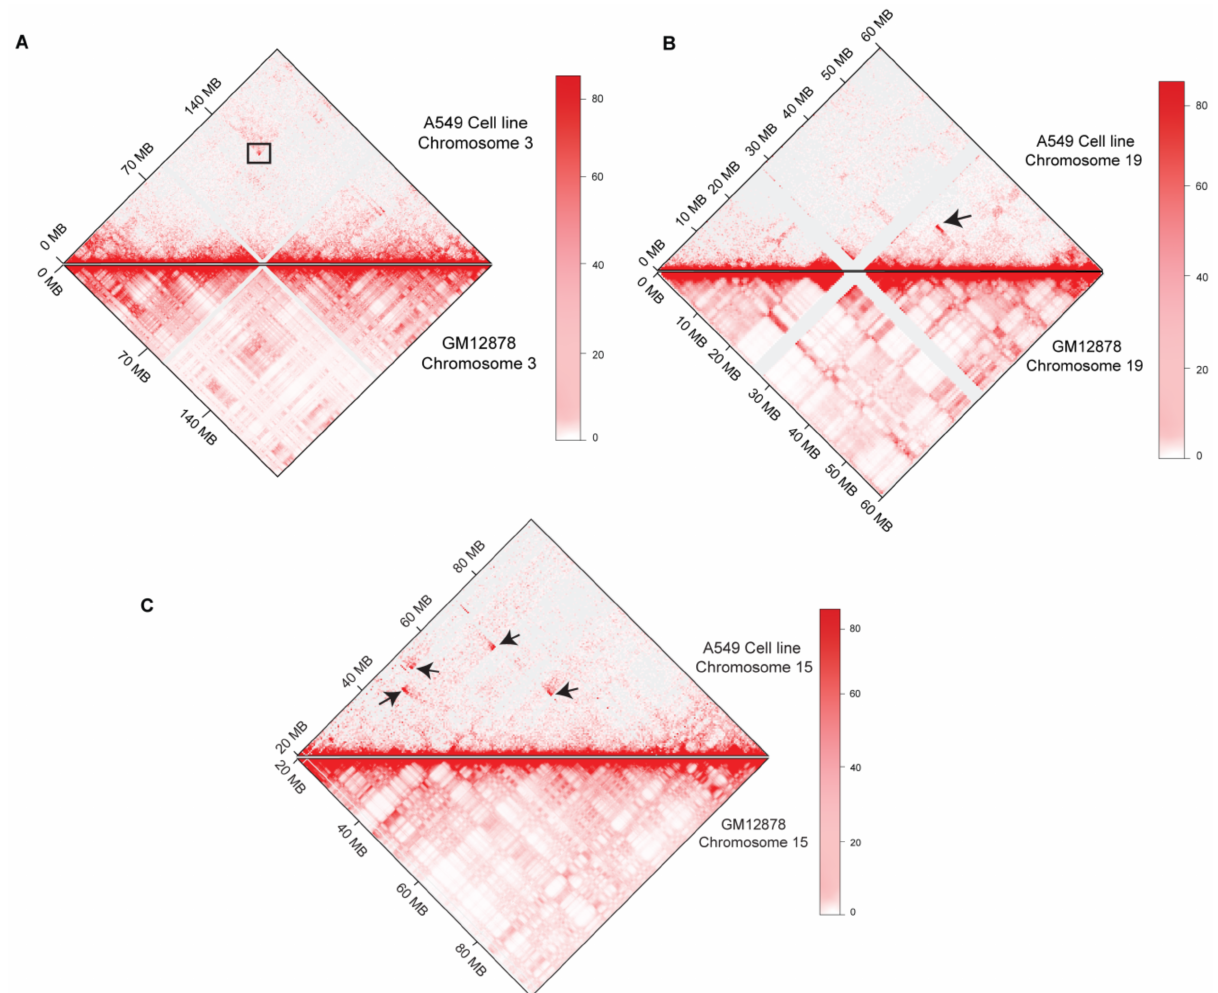
Figure 3. Differential Rearrangements at the chromosomal level in A549 cell line. Comparison between A549-Cell line (Upper panel) and Normal GM12878 (Lower panel) Hi-C at chromosomal level is shown ( A ) chromosome 3, ( B ) Chromosome 15, and ( C ) Chromosome 19. Changes are marked with black arrows and